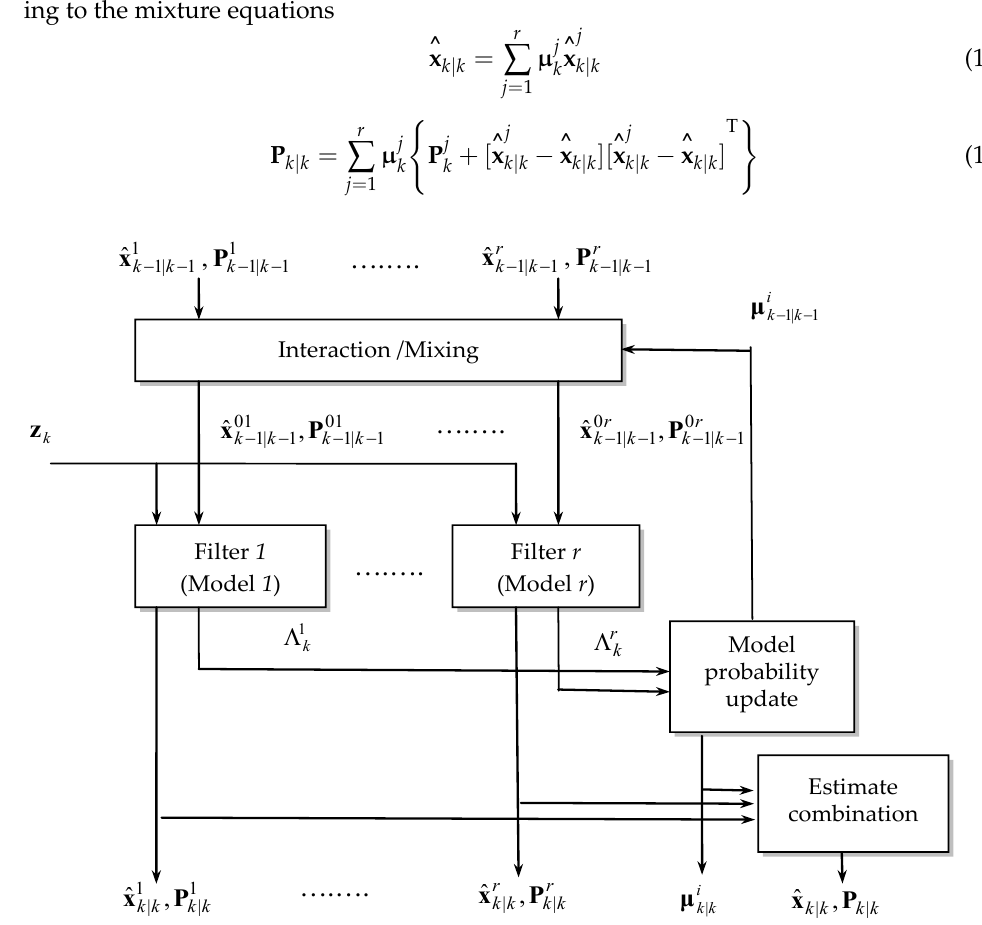
Figure 2. The block diagram of the IMM filter algorithm (one cycle with r models).